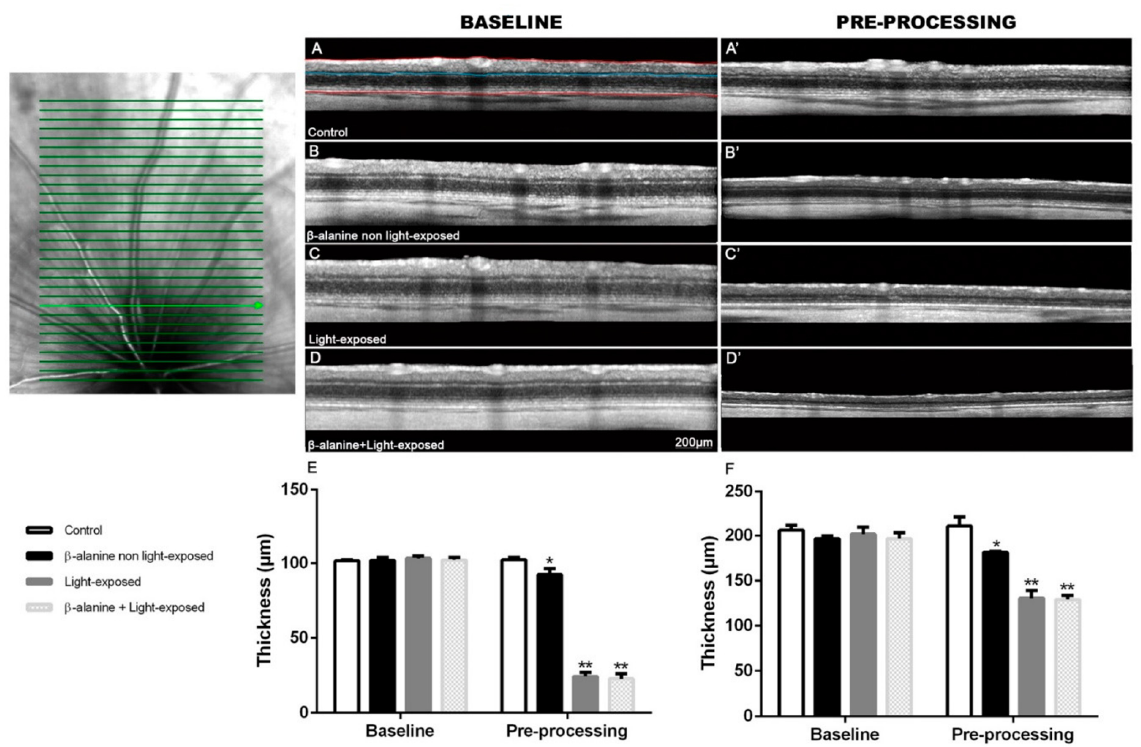
Figure 2. SD-OCT evaluation of total and outer retinal thickness. ( Upper Left ): Representative image of a scan image taken from a control animal that shows one of the cube scan protocols used: the dorsal. A similar ventral scan was also acquired in each animal. ( Upper right ): Representative SD-OCT scans obtained at baseline ( left column ) and pre-processing ( right column ) of same animals belonging to different subgroups: control ( A , A ′ ), β -alanine non light-exposed ( B , B ′ ), light-exposed ( C , C ′ ) and β -alanine and light-exposed ( D , D ′ ). In ( A ), the manually traced lines used for segmentation of the total retina are outlined in red and the line used for outer retina segmentation is outlined in blue just above the OPL. ( E , F ): Graphs showing mean ± SD outer retinal thickness ( E ) and mean ± SD total retinal thickness ( F ) in the different subgroups analyzed ( lower left ). * Significant difference when compared with pre-processing values of control animals p ≤ 0.0001. ** Significant difference when compared with pre-processing values of experimental group p ≤ 0.0001, Two-Way Anova test. Table 1. SD-OCT retinal thickness measurements in control and experimental animals.